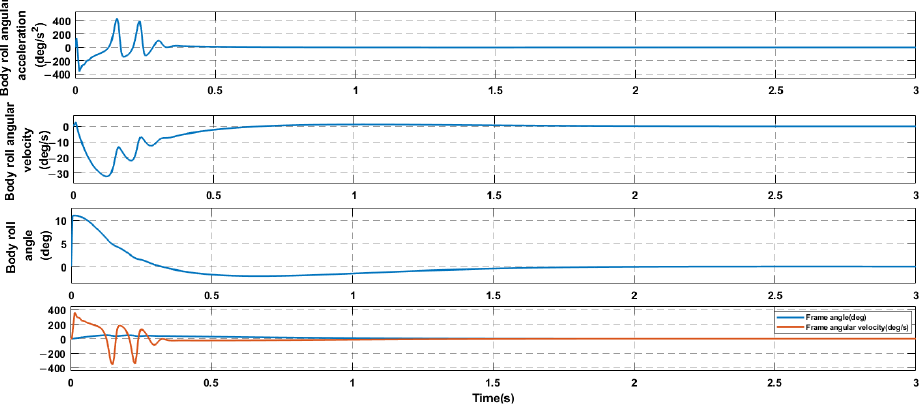
Figure 14. Simulation results: The initial conditions are [127.7°/s 2 , 2.6°/s, 11°, 0°].